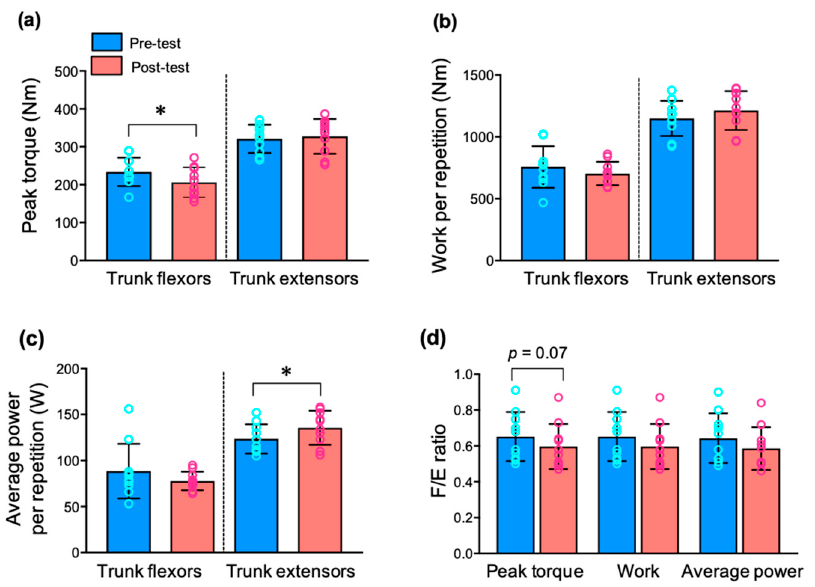
Figure 3. Change in isokinetic trunk strength following 8 weeks of Pilates training. ( a ) There was a significant change in peak torque of trunk flexors ( p < 0.05). ( b ) There was no significant change in work per repetition of trunk flexors and extensors. ( c ) Average power per repetition in trunk exten- sors increased in post-test ( p < 0.05). ( d ) Ratio of trunk flexion/extension strength (F/E) in post-test trended lower than that in pre-test ( p = 0.07). All values are presented as mean ± SD (n = 11). Note: * p < 0.05, vs. pre-test.